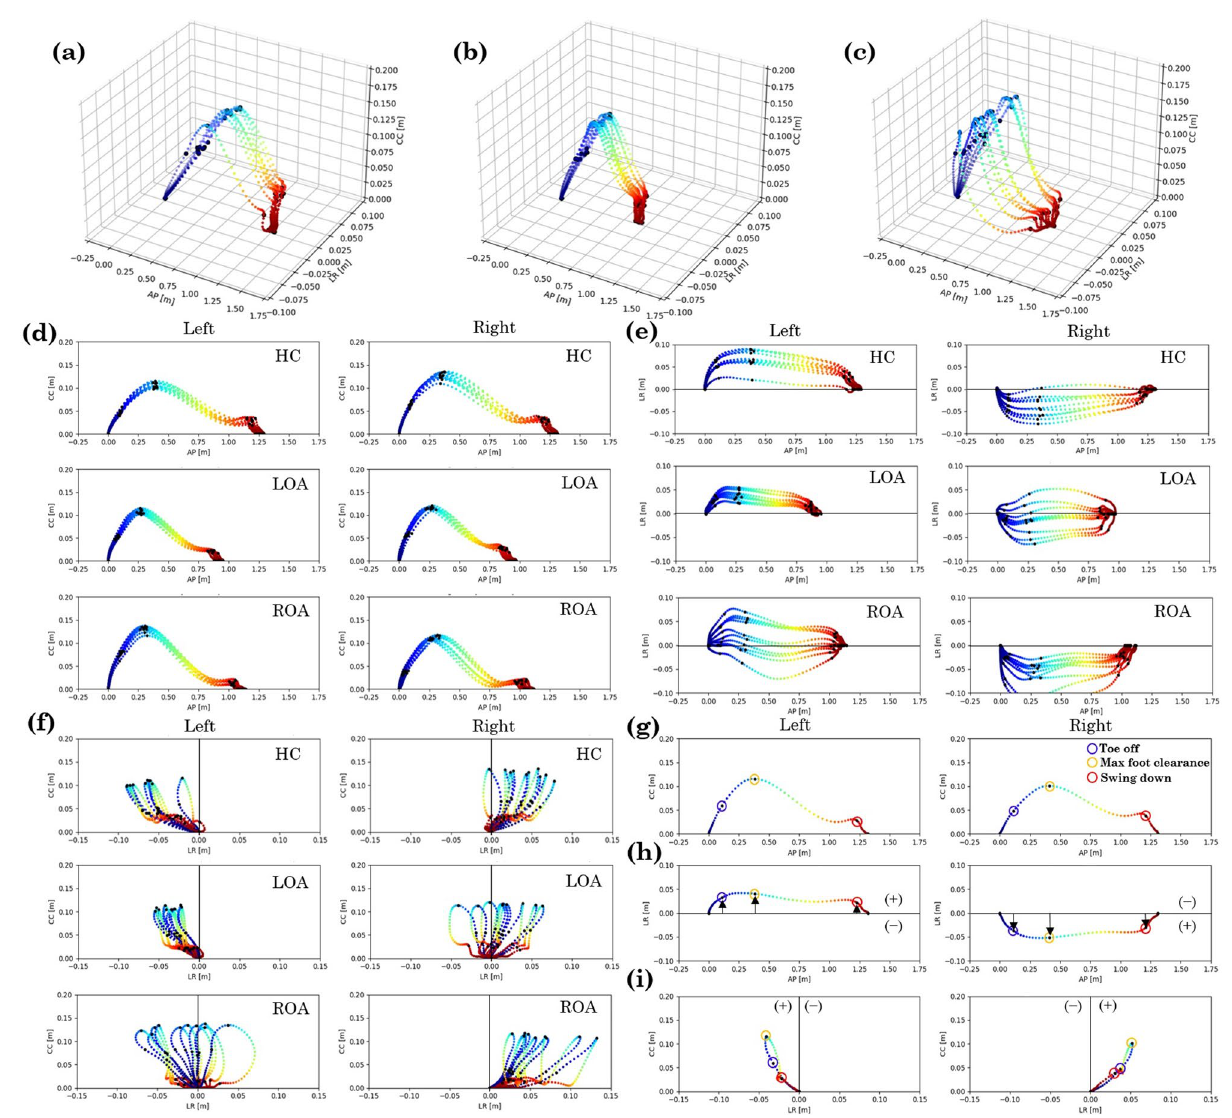
Figure 2. An example of the three-dimensions estimated foot trajectory obtained from shank during walking. ( a ) Three-dimensional foot trajectory of healthy control (HC) left leg, ( b ) left hip osteoarthritis (LOA) left leg, ( c ) right hip osteoarthritis (ROA) left leg. An example of ( d ) sagittal plane, ( e ) horizontal, and ( f ) coronal plane of the three-dimensional estimated foot trajectory obtained from shank during gait. An example of foot trajectory in the sagittal ( g ), horizontal ( h ), and frontal planes ( i ) for the left and right legs of HC. The black dots indicate the positions of toe off, maximum foot clearance, and swing down during the swing phase of walking ( g – i ). In the horizontal and frontal planes, the midline was set as 0, and the lateral distance (LD) from the midline was examined with the swing leg side as ( + ) and the stance leg side as (−) ( h , i ). The LD farthest from the midline to the swing legs side was defined as the maximum, and the LD closest to the stance legs side was defined as the minimum ( h ). From left to right and top to bottom: HC, LOA, ROA. Anterior-Posterior: AP, Cranio-caudal: CC, Left-right: